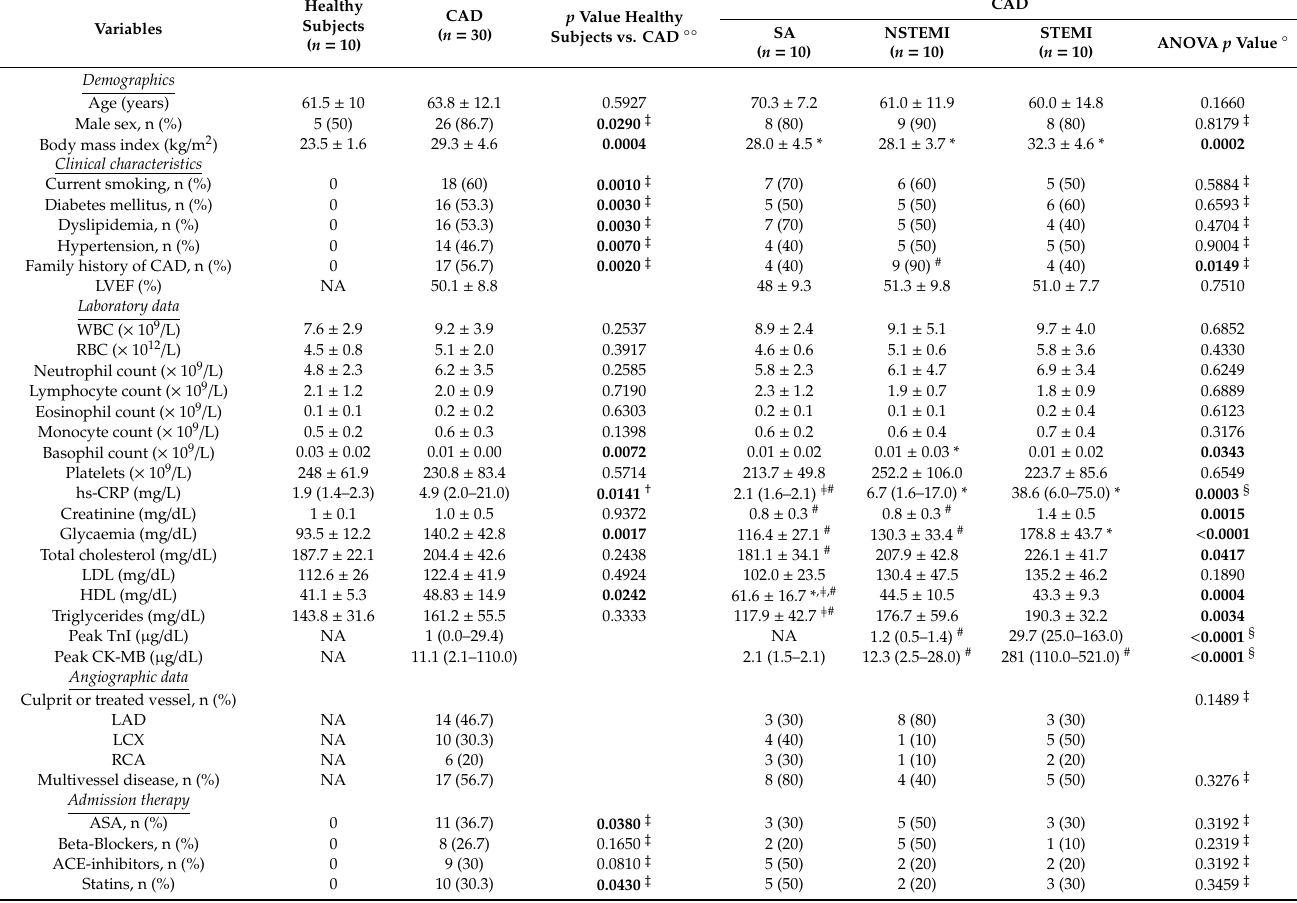
Table 1. Baseline clinical, laboratory, and angiographic characteristics of the study